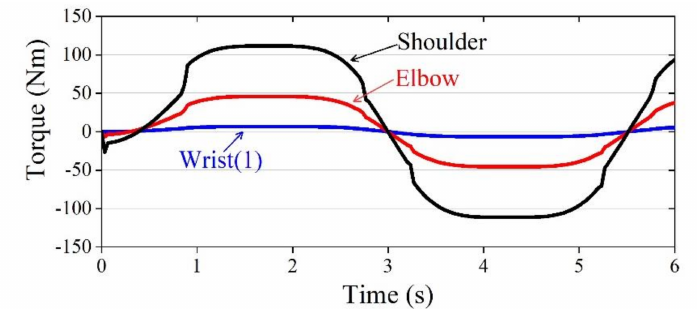
Figure 8. Required torque for each joint.